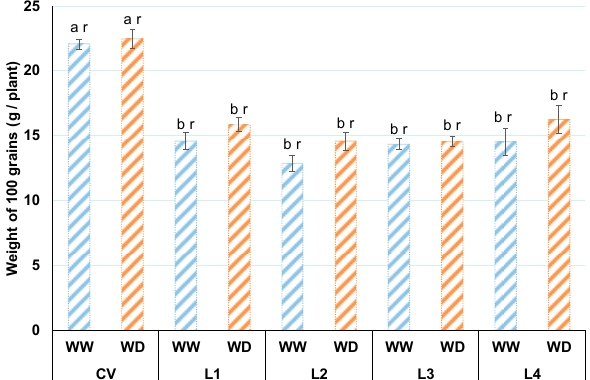
Figure 4. Weight of 100 grains (W100G) of Portuguese cowpea grains, a commercial variety (CV), and four landraces, L1, L2, L3, and L4, obtained under well-watered (WW) and water deficit (WD) conditions. Values represent mean ± SE ( n = 5 to 10). Different letters mean significant differences between varieties (a, b, c) and between treatments for each variety (r, s). The letters (a) and (r) correspond to the highest values. (ANOVA, p < 0.05).